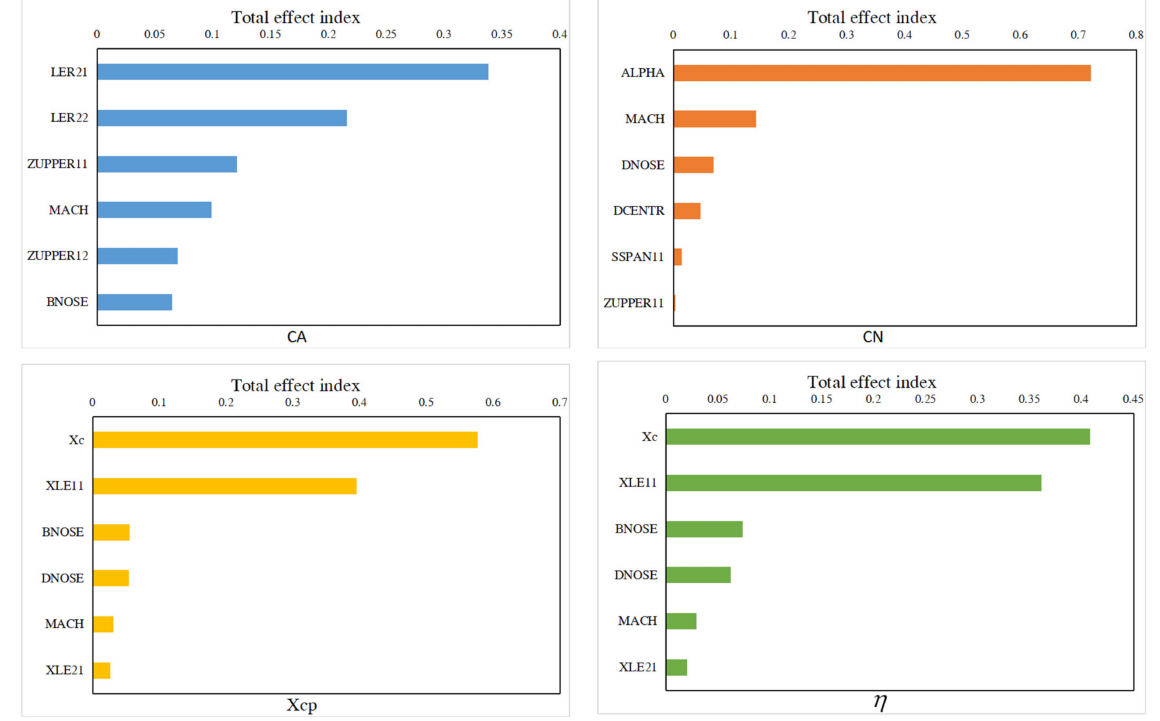
Figure 14. Total effect index of each